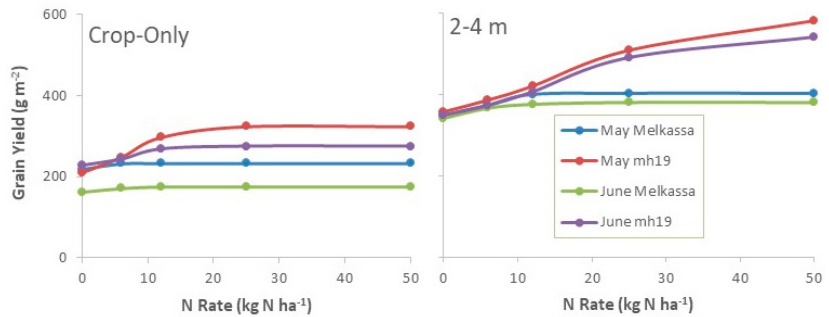
Figure 3. Maize yield response to N fertilizer rate in relation to sowing date (15 May or 30 June) and cultivar (Melkassa or mh19) in the crop-only and 2–4 m zones with 100% pruning in the 2016 cropping